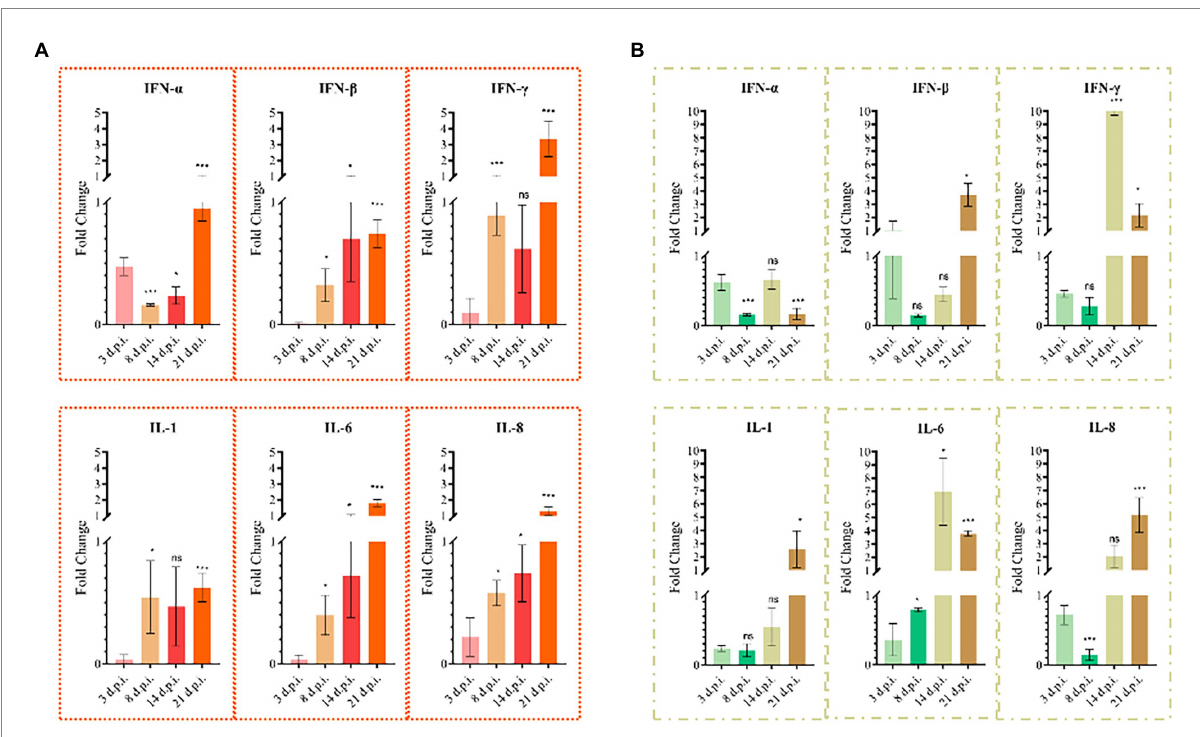
FIGURE 7 Cytokine changes in chicken thymus and bursa ( n = 4/group). (A) Cytokine changes in the bursa. (B) Cytokine changes in the thymus. All columns show average Mean ± SD values.